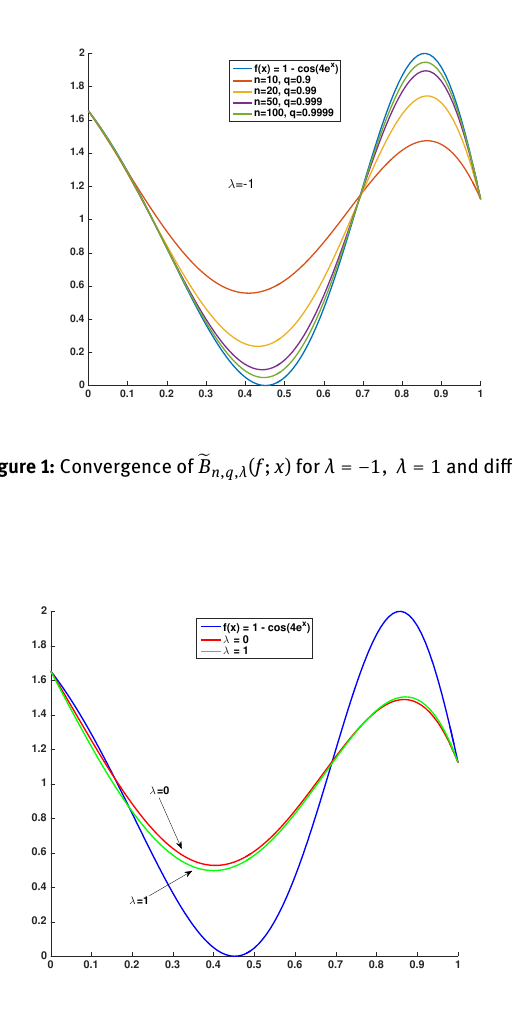
Figure 2: Convergence of (cid:101) B 10,0.9, λ ( f ; x ) for λ = 1 and λ = 0